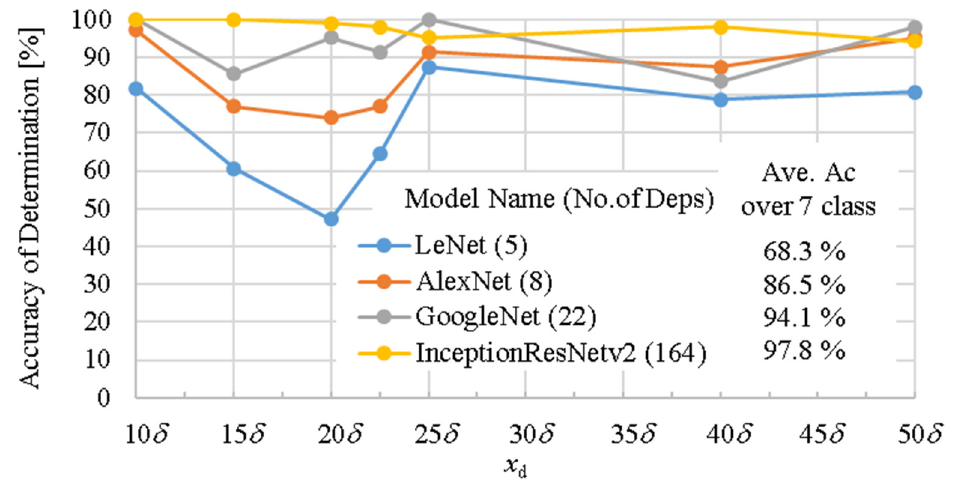
Figure 2. Accuracy of determination of W0.9 δ by each network model including different network depths. The average accuracy over seven classes (i.e., seven different x d ) are also shown.